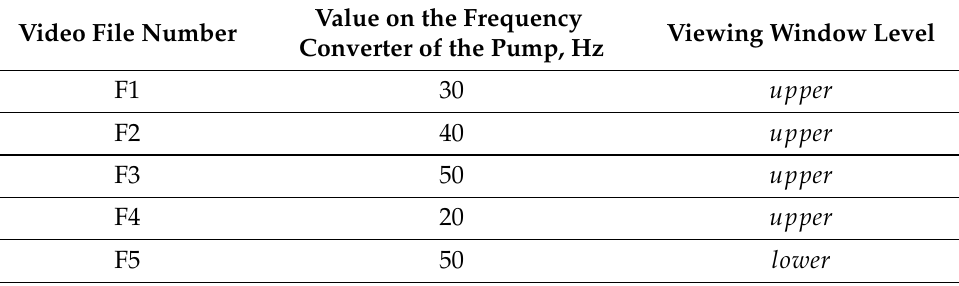
Figure 1. Schematic representation of the experimental hydrodynamic stand for the bubble flow study. Geometry and technical characteristics of the stand designed in accordance with jet bioreactor circuit. Table 1. Correspondence between settings and video files for analysis: experiment was conducted and the corresponding data analyzed for the set of bioreactor modes